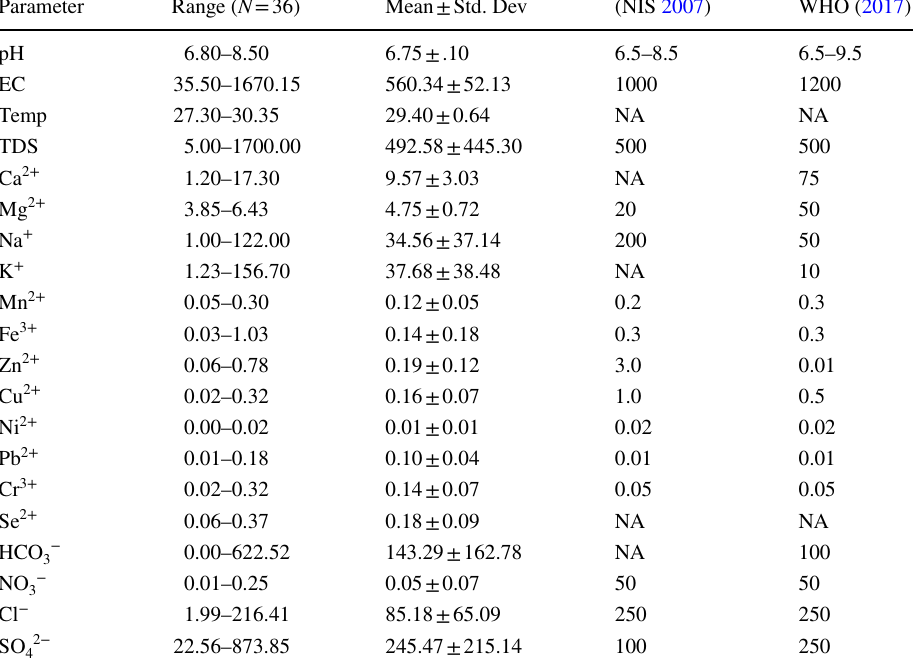
Table 1 Summary result of the physicochemical parameters of the